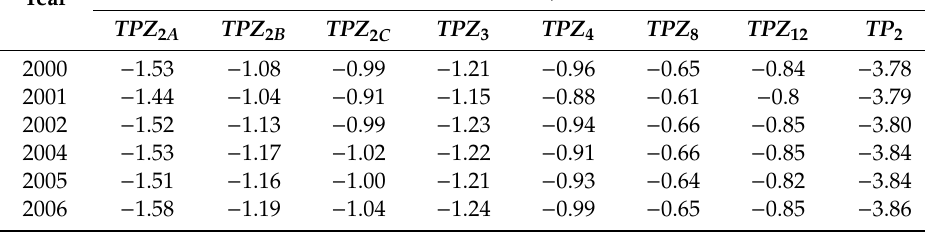
Table 2. Average annual water table depths in piezometers ( TPZ ) and observation wells ( TP ) used for the construction of a model for the prediction of the surface covered with vegetation in the salt meadows of Tilopozo, during the period,